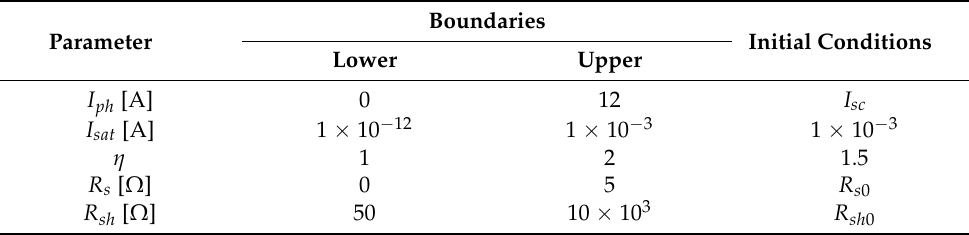
Table 2. Initial values and boundaries for the